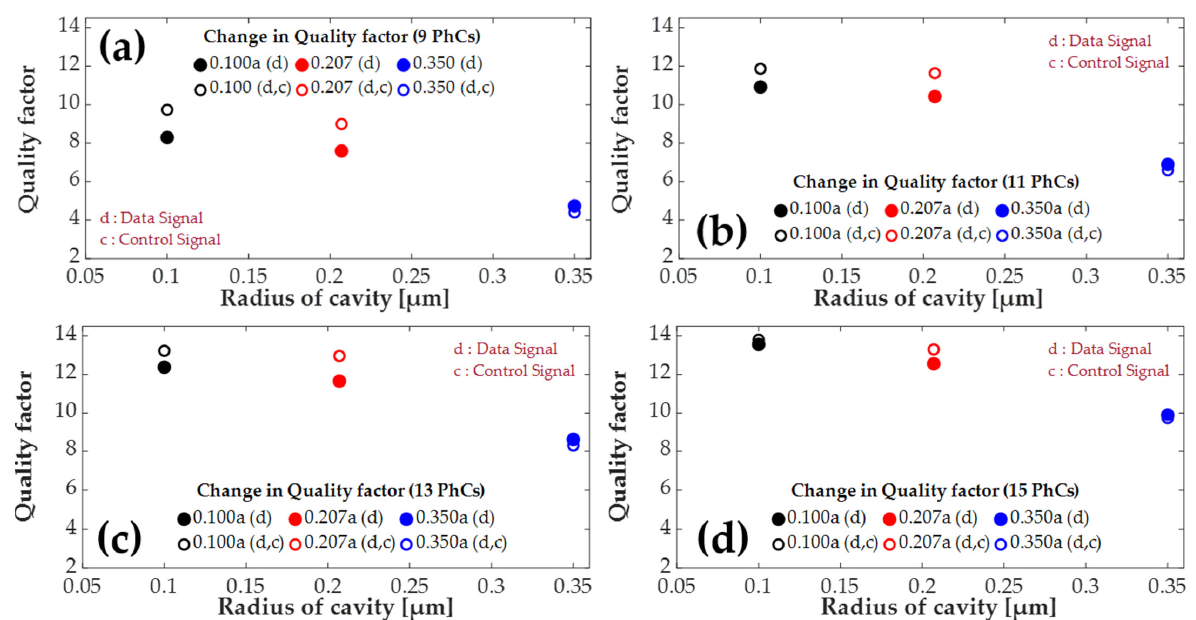
Figure 12. Quality factor of data signal before and after amplification for different number of PhC-elements and cavity-radii of 0.100a, 0.207a and 0.350a. Single source excitation is shown in solid circles and dual source action in hollow circles. ( a ) 9 PhC-elements. ( b ) 11 PhC-elements. ( c ) 13 PhC-elements. ( d ) 15 PhC-elements. Table 3, gathers a detailed overview of the spectral characteristics of all the investi- gated PhCs structures with different numbers of PhC-elements and cavity-radii for both single and dual source action. The reported spectral characteristic includes 𝜔 (cid:3030) , reflection peaks and linewidth. By analyzing these parameters, an appropriate design of the optical switch can be chosen to yield the desired spectral characteristics for a specific application. Table 3. Comparative analysis of spectral characteristics of different designs of the proposed optical switch for single (data signal) and dual source (data and control) action.